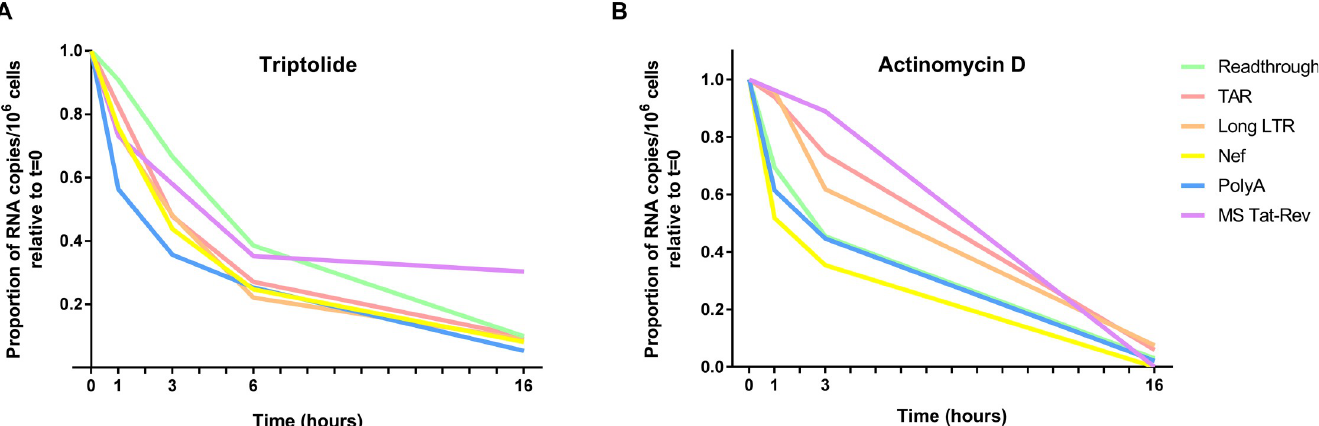
Fig 3. Stability of HIV transcripts ex vivo . Peripheral CD4+ T cells were isolated from an ART-suppressed individual and treated with the RNA polymerase II (RNA Pol II) inhibitors (A) Triptolide [100 nM] or (B) Actinomycin D [5 mg/mL] to arrest de novo cellular and viral transcription. HIV transcripts (Read-through, TAR, Long LTR, Nef, PolyA, and MS Tat-Rev) were quantified using RT-ddPCR from cells harvested at various time points post-treatment. Levels of each HIV RNA were expressed as a proportion of the level at time t = 0 (shown) and the half-lives were determined using a one-phase exponential decay model. Data normalized to DNA mass are